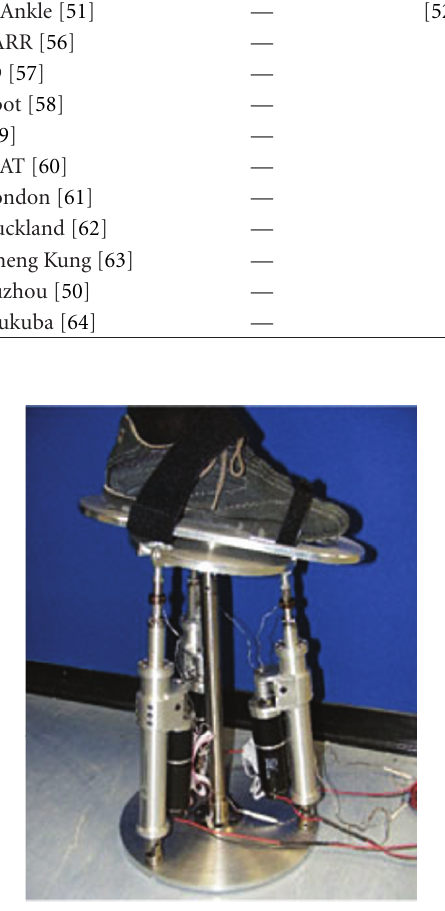
Figure 11: High Performance Ankle Rehabilitation Robot devel- oped at the Istituto Italiano di